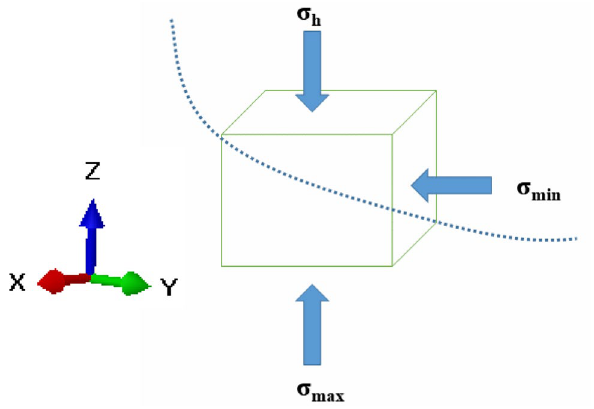
Fig. 1 Schematic diagram of in situ stress full